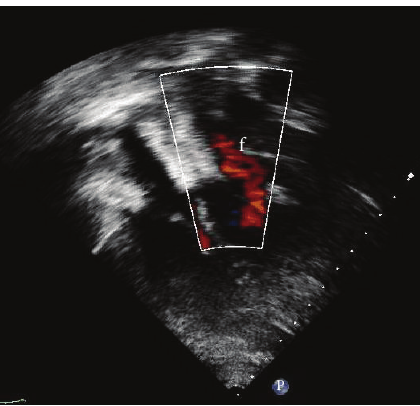
Figure 4: TEE after procedure demonstrate no obstruction blood flow through fenestration of cor triatriatum membrane (f).